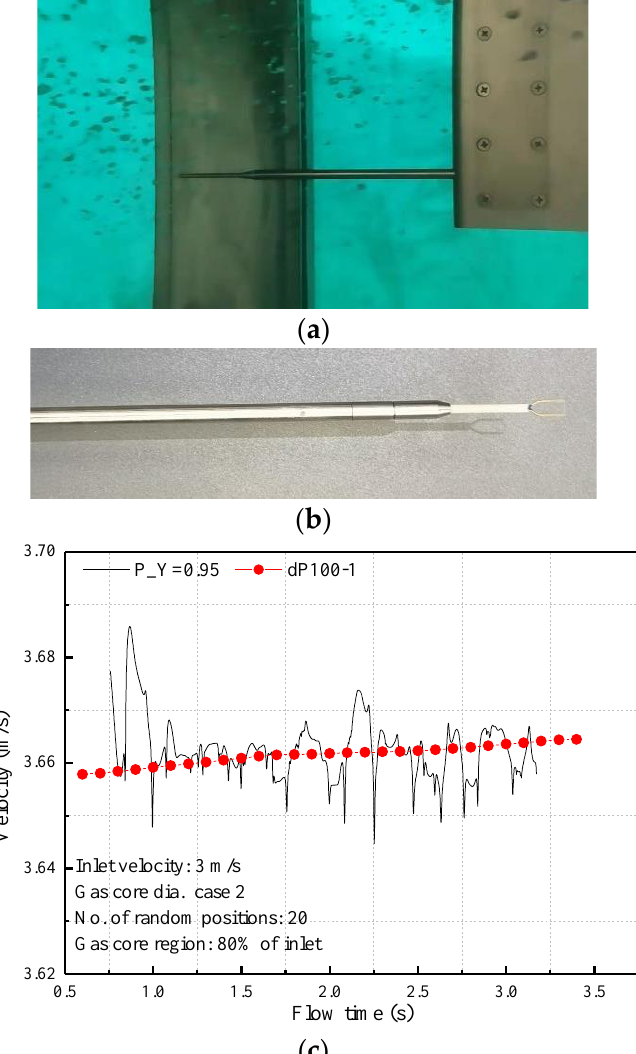
Figure 2. Comparison of experimental data with simulation results: ( a ) test section of experimental apparatus, ( b ) hot film meter for water measurement, and ( c ) comparison of instantaneous velocity results (CFD simulation and experiment results).